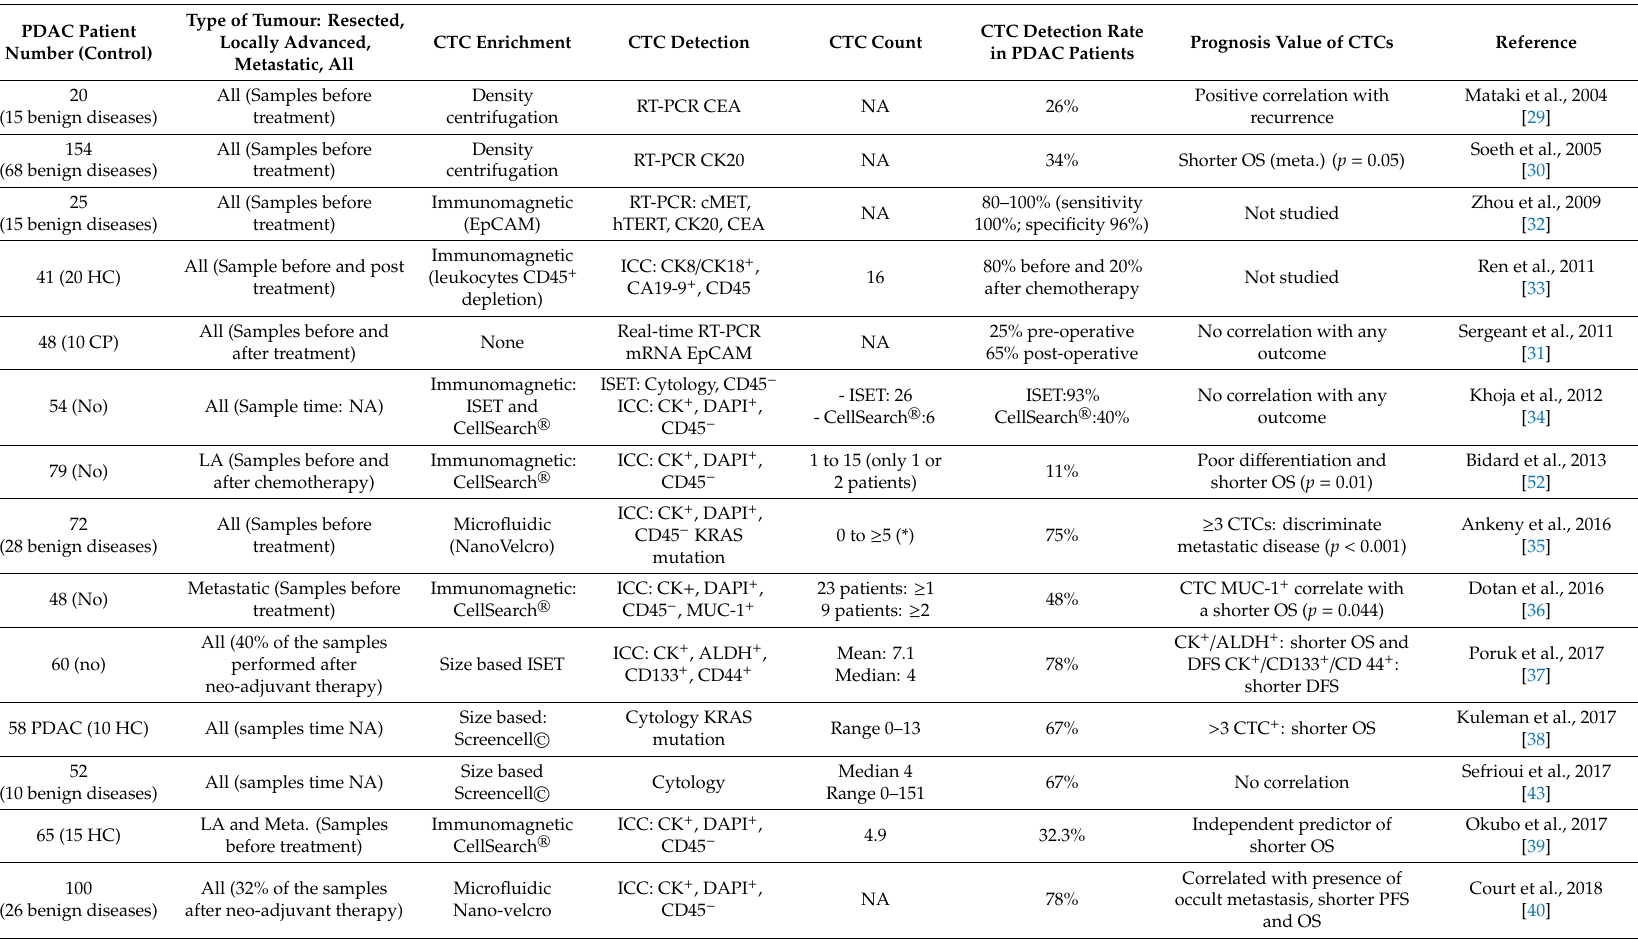
Table 1. Results of main clinical pilot studies assessing performances of circulating tumour cells (CTCs) detection in the diagnosis and prognosis of pancreatic ductal adenocarcinoma